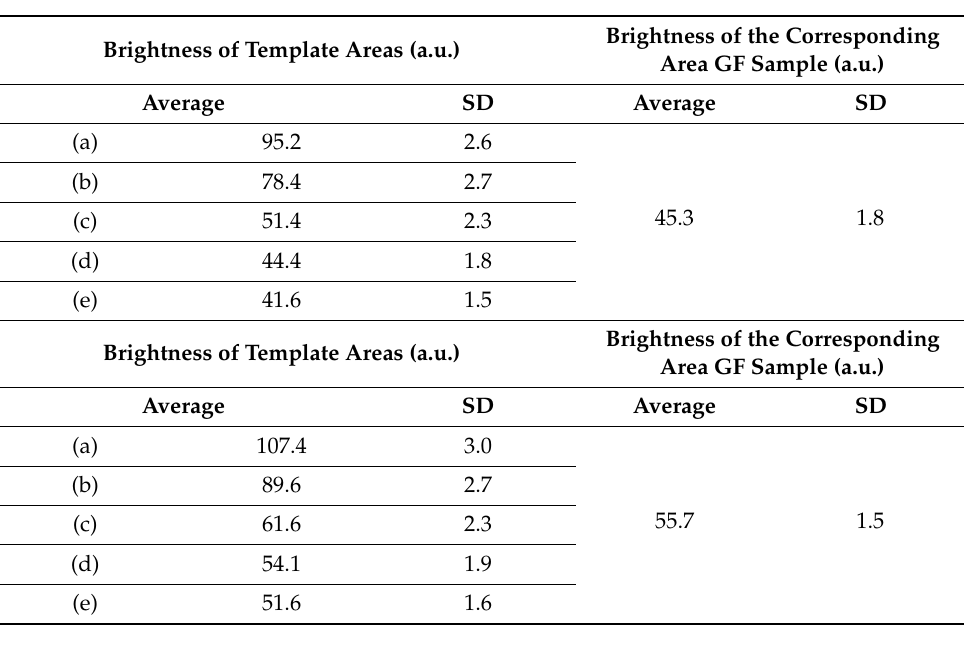
Table 1. Brightness of the reference areas and areas covering the tested chocolate samples on standardized micromographic